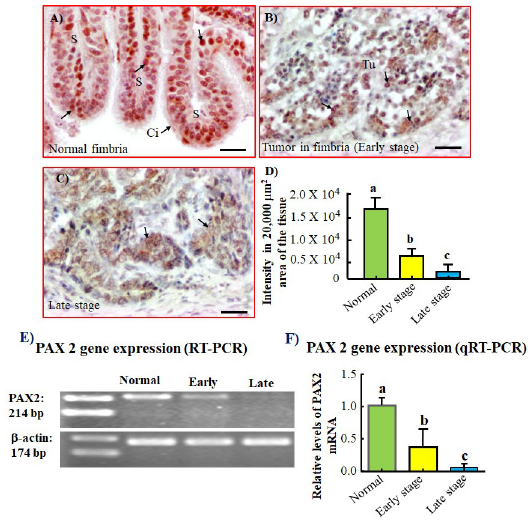
Fig 6. Changes in PAX2 expression during tumor development in oviductal fimbriae in hens. A) Section of a normal fimbria in a healthy hen showing strong staining for PAX2 by the surface epithelial cells. (B and C) Sections of fimbriae with tumor at early (B) and late (C) stages. In contrast to normal fimbria, malignant cells in fimbriae with tumors showed weaker staining for PAX2. (D) Intensity of immunohistochemical expression of PAX2. Compared with normal fimbria, the intensity of PAX2 was significantly lower in fimbriae with tumor at early stage and decreased further in late stage ( P < 0.0001). (E and F) semi-quantitative (E) and quantitative (F) gene expression assays showed significant decrease in PAX2 expression during tumor development and progression ( P < 0.001). Bars with different letters are significantly different. Intensity or fold change values in (D) and (F), respectively, are arbitrary values presented as mean ± SEM. Ci = Cilia. S = Stroma, Tu = Tumor. Scale bar = 20 μ